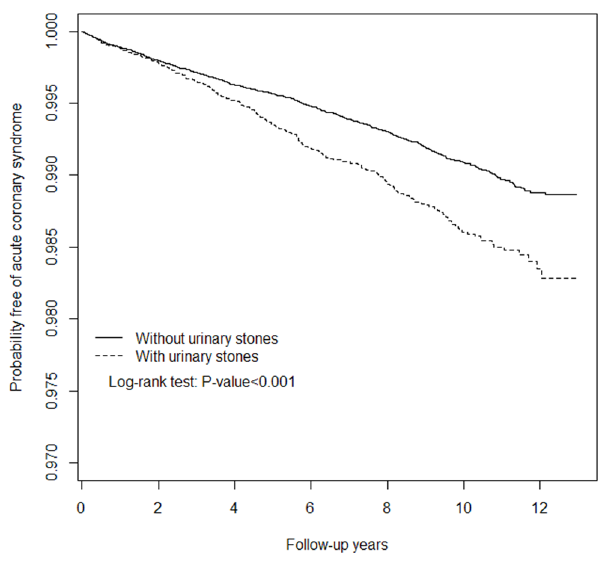
Figure 1. Probability free of acute coronary syndrome for patients with (dashed line) or without (solid line) urinary stones.